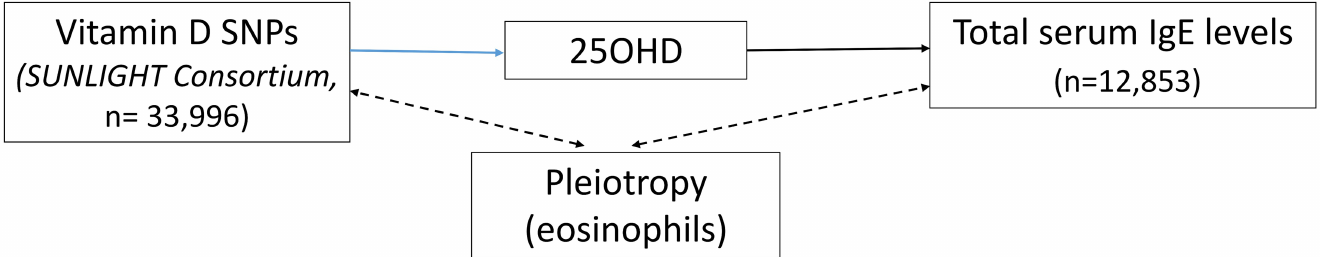
Fig 3. Direct Acyclic Graph (DAG) of the Mendelian randomization analysis for Immunoglobulin E (IgE) levels. The effect of single-nucleotide polymorphisms (SNPs) on the change in natural log-transformed 25-hydroxyvitamin D (25OHD) levels. SUNLIGHT, Study of Underlying Genetic Determinants of Vitamin D and Highly RelatedTraits.